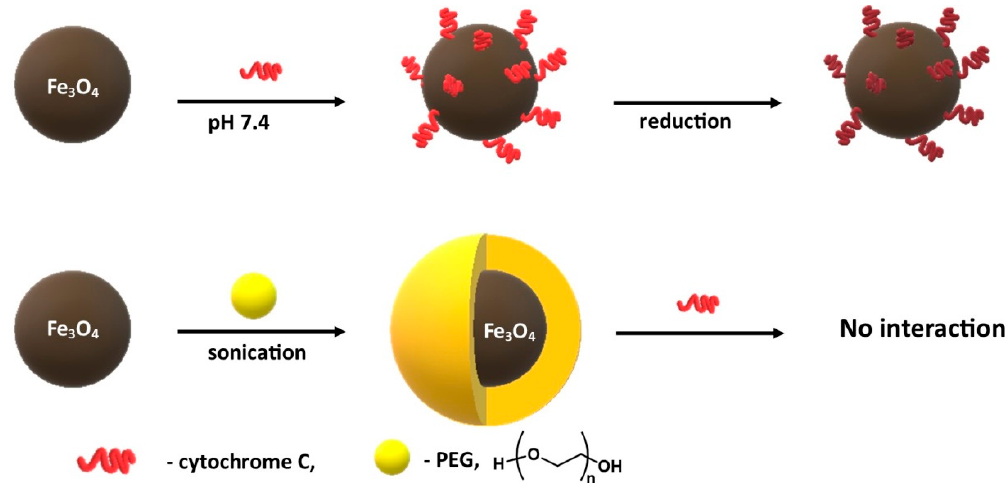
Figure 8. Schematic representation of the interaction of Cytochrome C with the bare and polyethylene glycol (PEG)-coated Fe 3 O 4 MNPs.